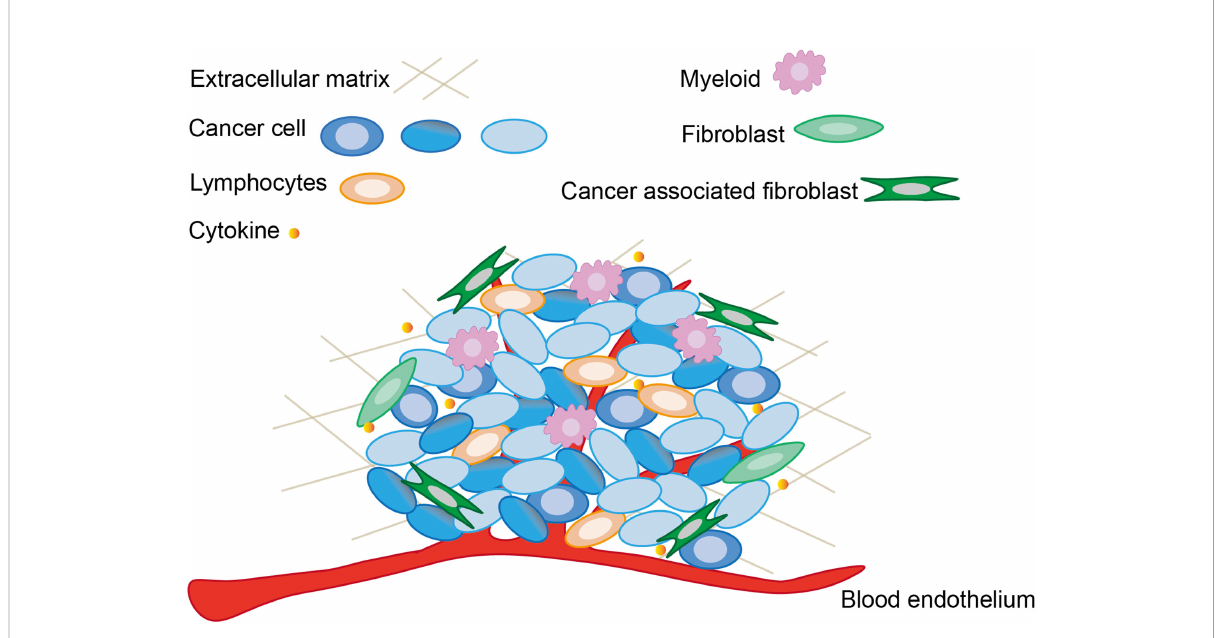
FIGURE 1 The main components and associated cells within tumor microenvironment. The tumor microenvironment not only contains cancer cells and already altered cellular structures, but is also capable to recruit normal cells and release cytokines to sustain the function of tumor